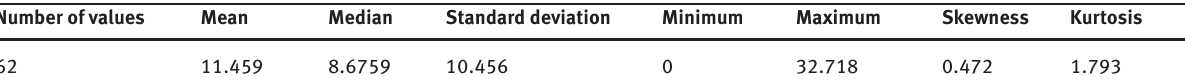
Table 3: Basic statistics of liquefaction potential index.